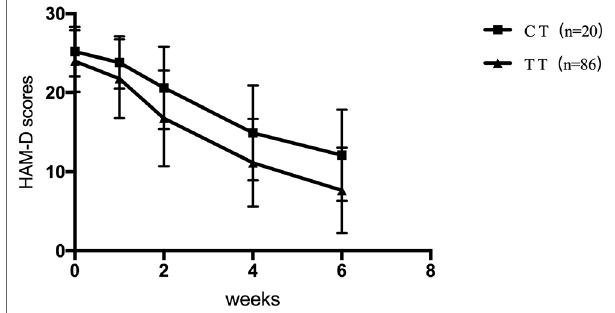
FIGURE 2 | HAM-D scores at the first, second, fourth, and sixth week